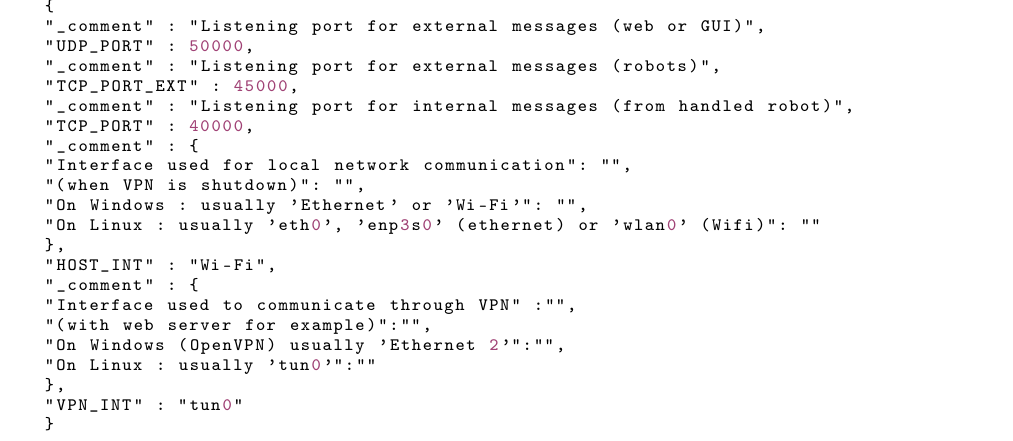
Figure A2. Network configuration